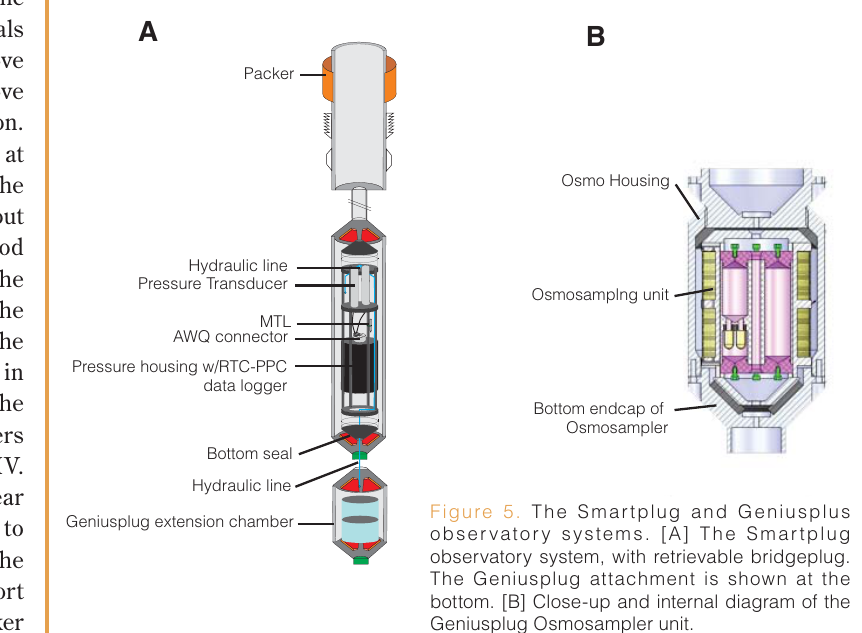
Figure 5. The Smartplug and Geniusplus observatory systems. [A] The Smartplug observatory system, with retrievable bridgeplug. The Geniusplug attachment is shown at the bottom. [B] Close-up and internal diagram of the Geniusplug Osmosampler